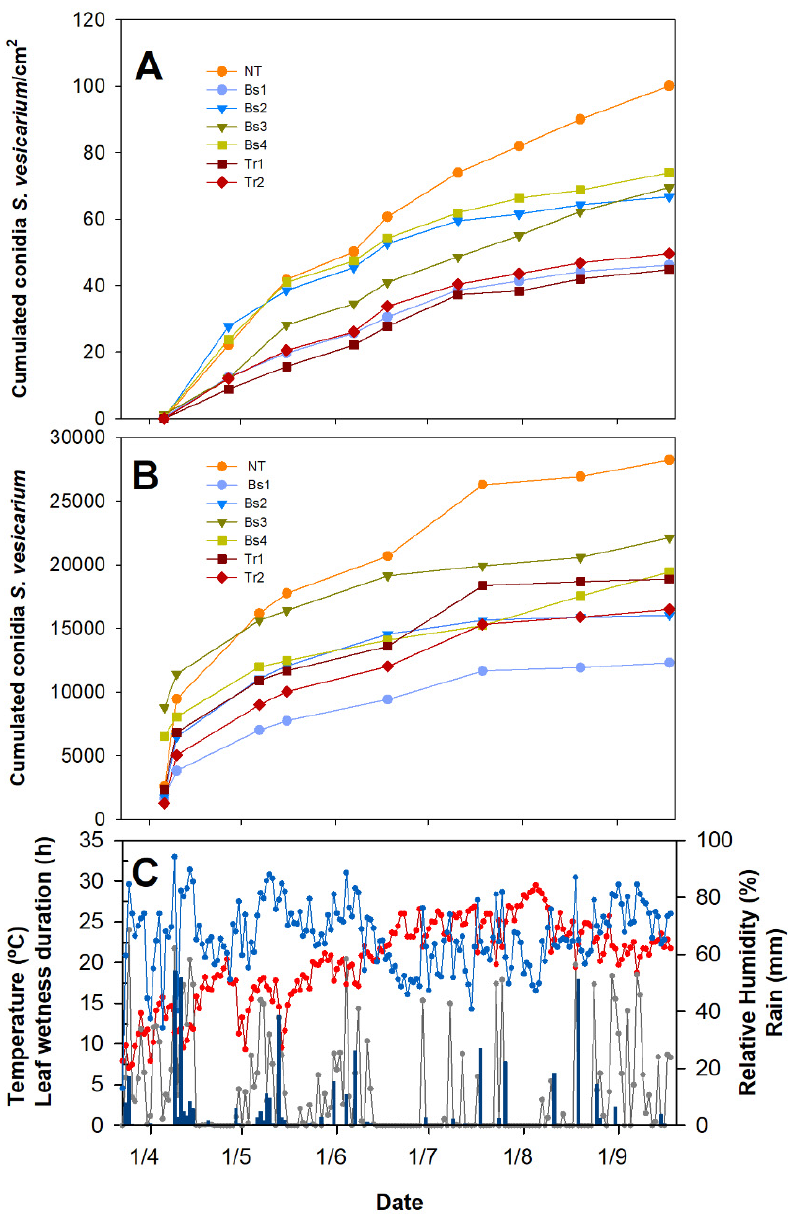
Figure 4. Dynamics of Stemphylium vesicarium observed in trials 1 ( A ) and 2 ( B ) under orchard conditions; ( C ): dynamics of Relative Humidity ( • ), Mean daily temperature ( • ), daily wetness duration ( ▬ ) and rain (bars). Conidia were trapped with mechanical spore-traps ( A ) or rain-catch traps ( B ). The results presented are the accumulated captured conidia. In trial 1 ( A ) conidia of S. vesicarium /cm 2 is shown whereas in trial 2 ( B ) the total of conidia caught of each period is shown. Biological control agents used were Bacillus subtilis strains (Bs1, Bs2, Bs3, Bs4) and Trichoderma spp. strains (Tr1, Tr2). NT: non-treated control.